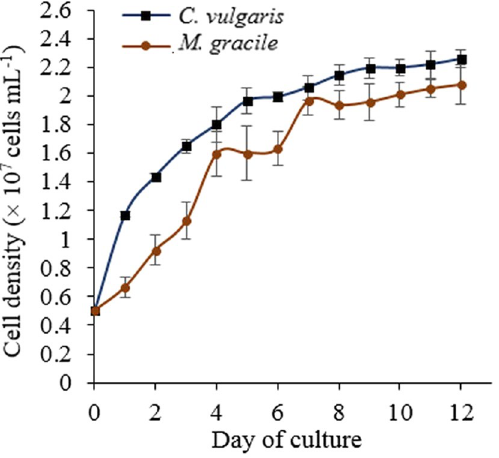
Figure 1. The growth curve of C. vulgaris UMT-M1 and M. gracile SE-MC4 cultured under nitrate deficient condition. The cultures were harvested at stationary growth phase when cell growth became plateau. Data shown as the mean ± SD, n =